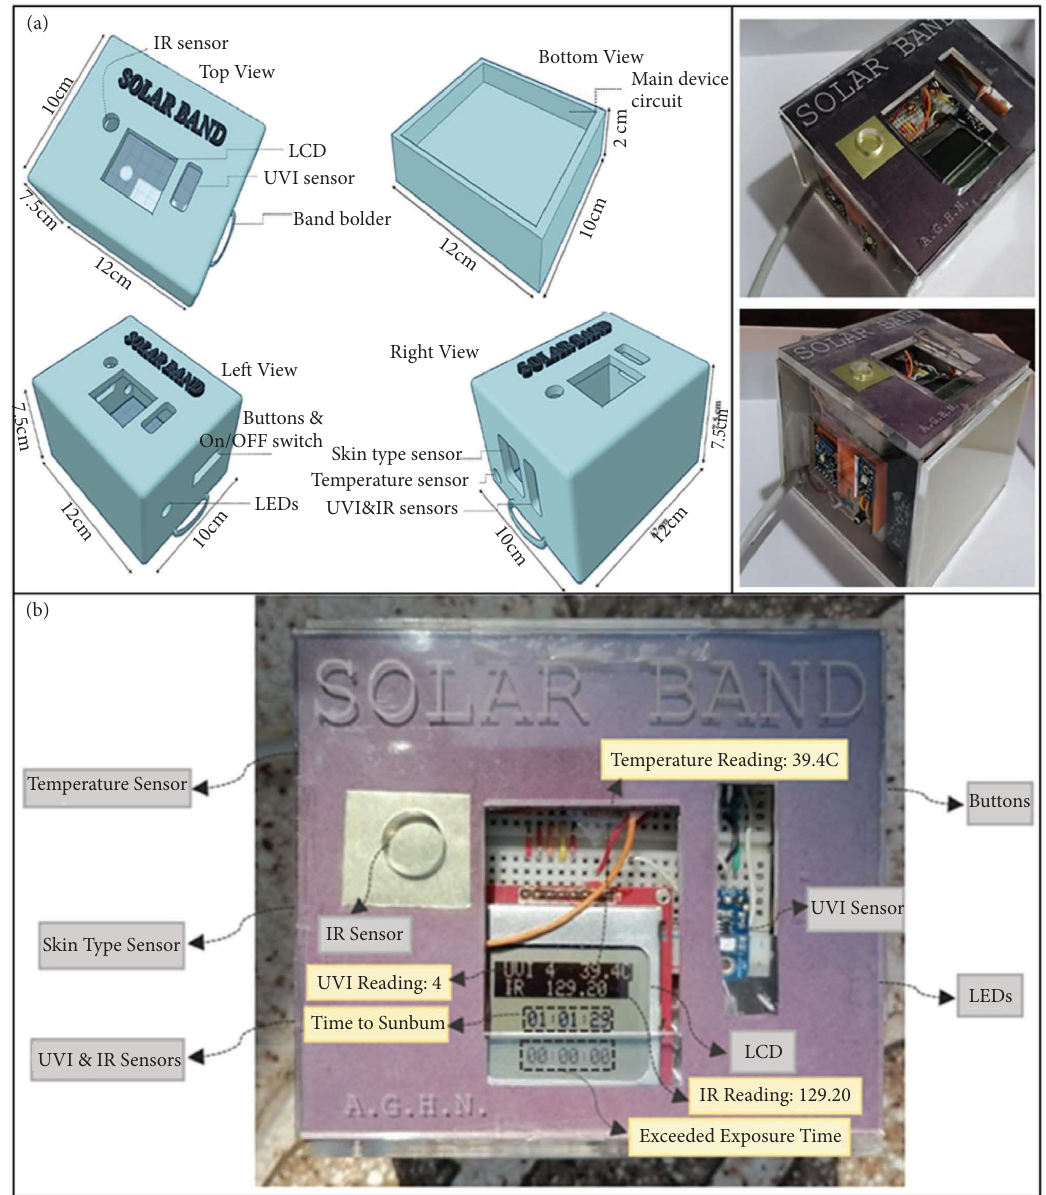
Figure 11: (a) 3D design of prototype with upper and lower views with real images. (b) Te solar band prototype with labeled components (grey boxes) and UVI, IR irradiance, and temperature reading (yellow